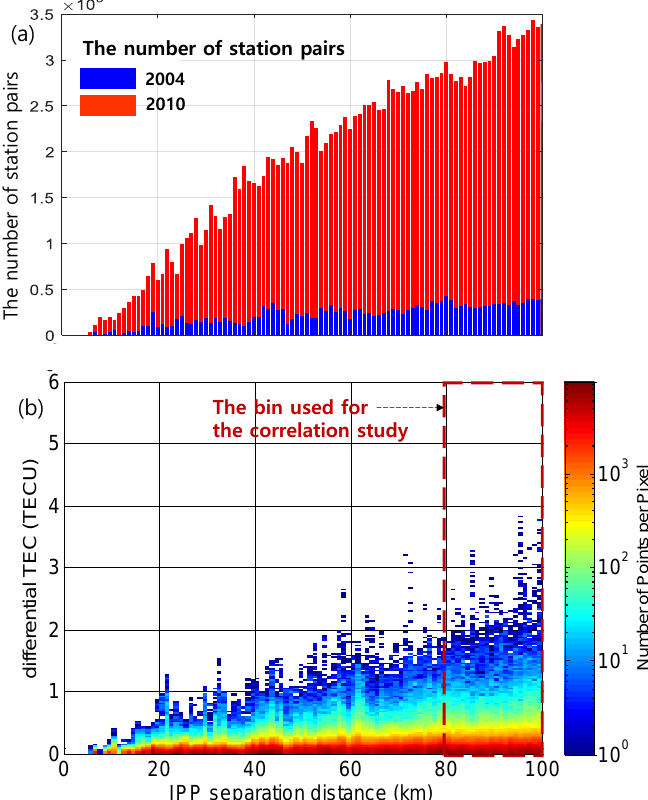
Figure 2. A number of station pairs used to derive vertical total electron content (TEC) statistics ( a ) and a differential TEC histogram on 26 July 2004 (a disturbed day) as a function of ionospheric pierce point (IPP) separation distances ( b ).